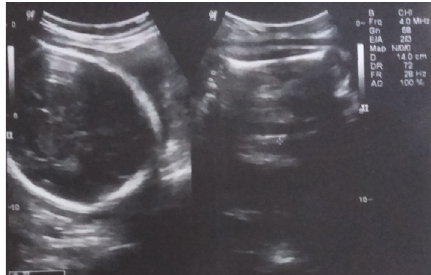
Figure 3: Obstetric ultrasound of the